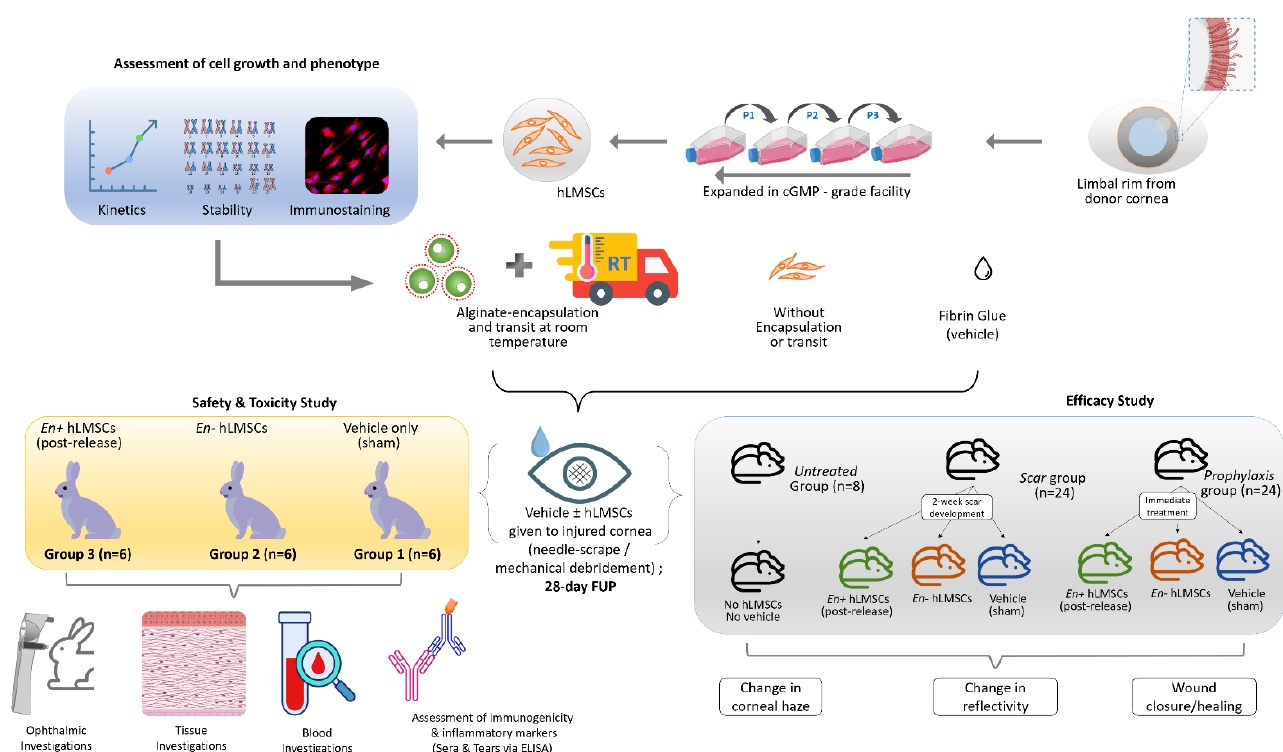
Figure 1. Graphical abstract of the experimental plan for assessing the safety and efficacy of human limbus − derived stromal/mesenchymal stem